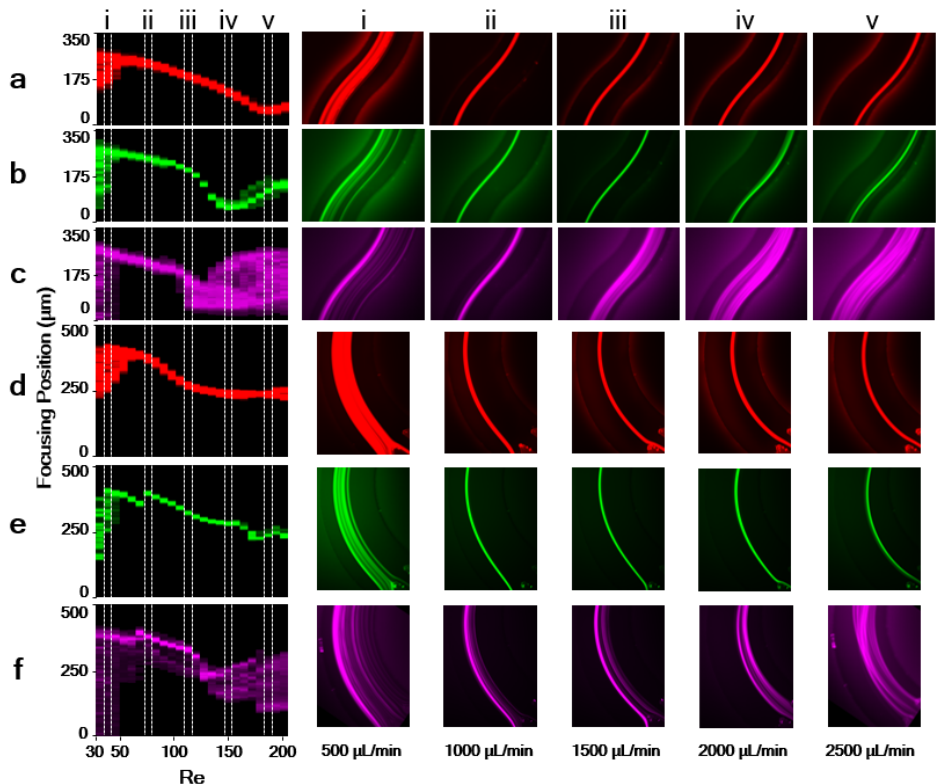
Figure 3. Re maps of the asymmetric curvilinear microchannel in the transition region for microparticles of ( a ) 20 µm, ( b ) 15 µm, and ( c ) 10 µm diameter, and in the outlet region for the microparticles of ( d ) 20 µm, ( e ) 15 µm, and ( f ) 10 µm diameter. (i–v) Real images of the particles flow at the five rates indicated (main flow direction is downward in all the images).